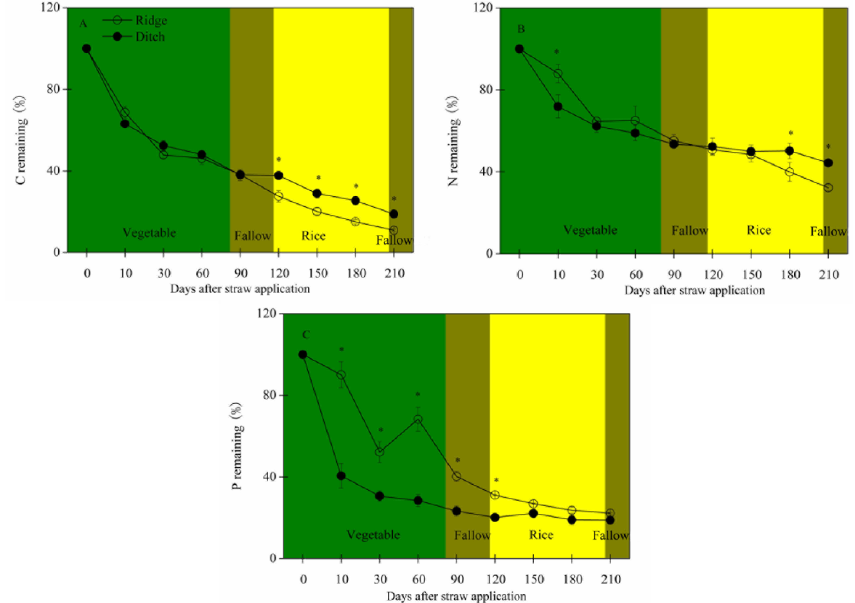
Figure 3. The dynamic changes of residual carbon (C) ( A ); residual nitrogen (N) ( B ); and residual phosphorus (P) ( C ) concentrations during rice straw decomposition. Statistically significant differences ( p < 0.5) between ridges and ditches in each sampling date are highlighted with (*). 2.2. Residual Straw Mass and Nutrients, Nutrient Release, and Influencing Factors